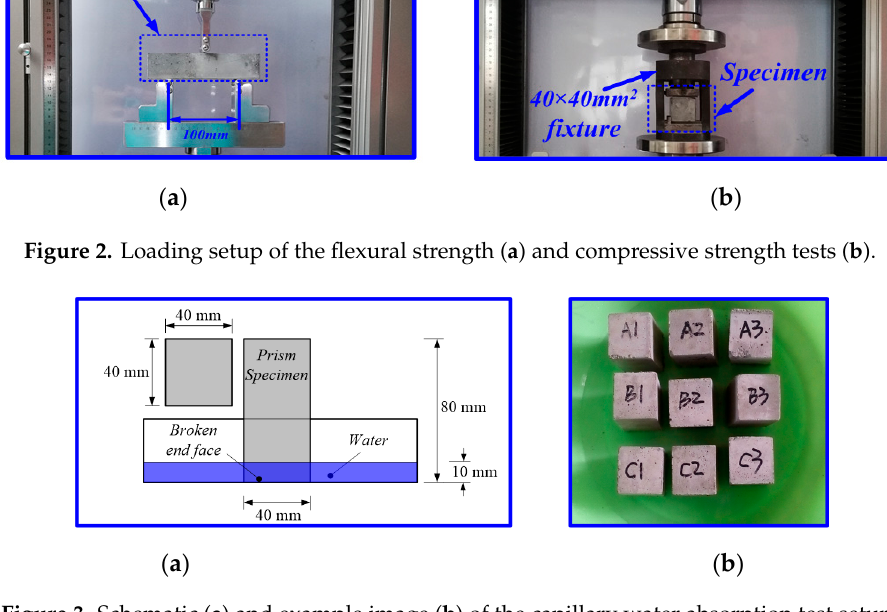
Figure 3. Schematic ( a ) and example image ( b ) of the capillary water absorption test setup.